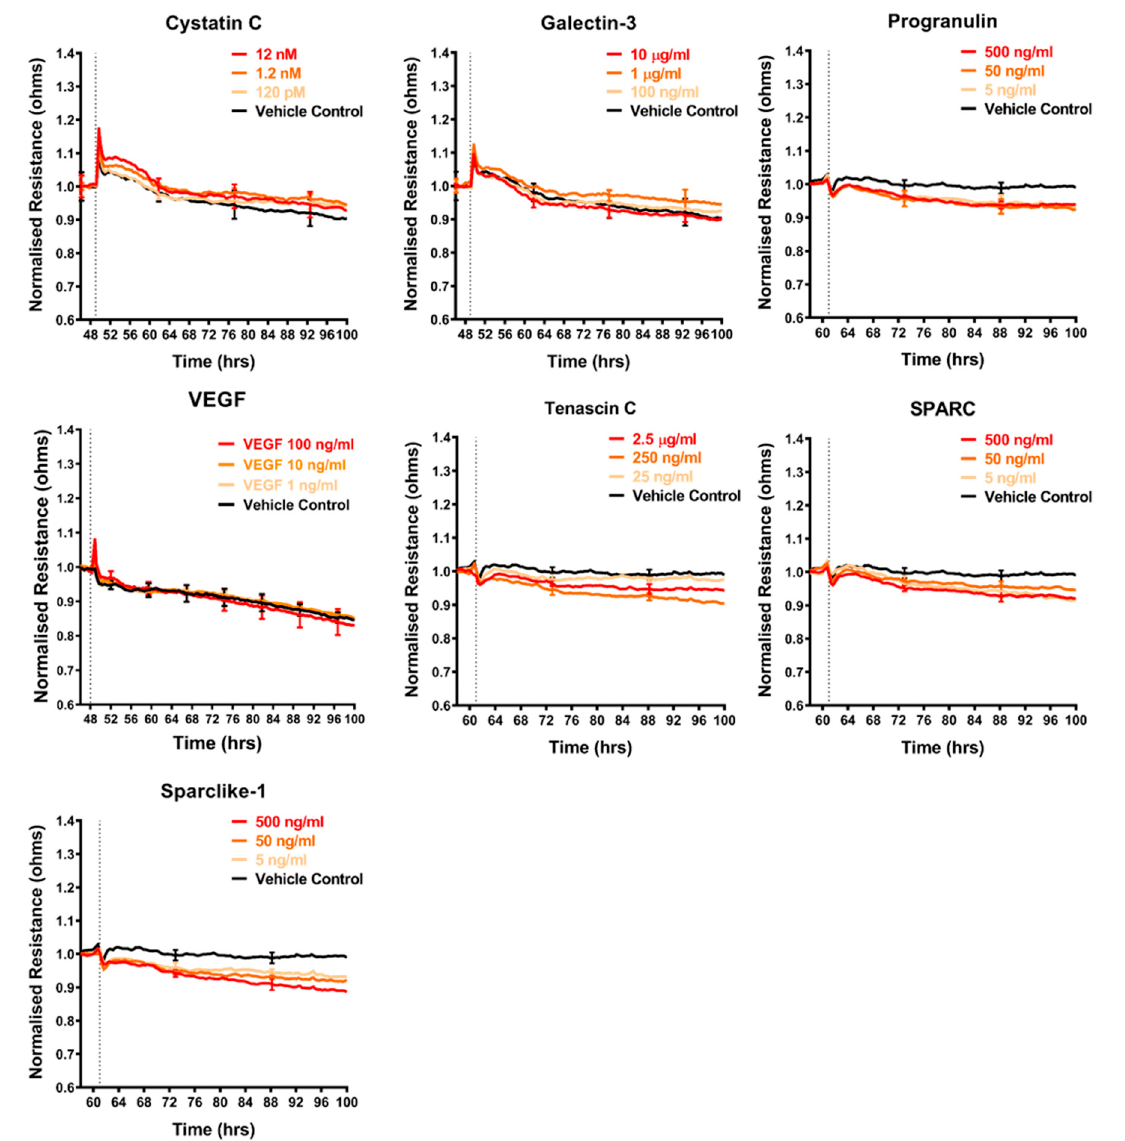
Figure 6. Effect of secreted protein on brain endothelial barrier resistance. Normalised unmodelled resistance (at 4000 Hz) of hCMVECs over time after addition of seven variably expressed secreted proteins. Recombinant proteins were added (dotted line) at top concentrations as recommended by the supplier and literature in a dilution series of 1:10. Data show the mean ± SD ( n = 3 wells) from one experiment, which is representative of two to three independent experiments.